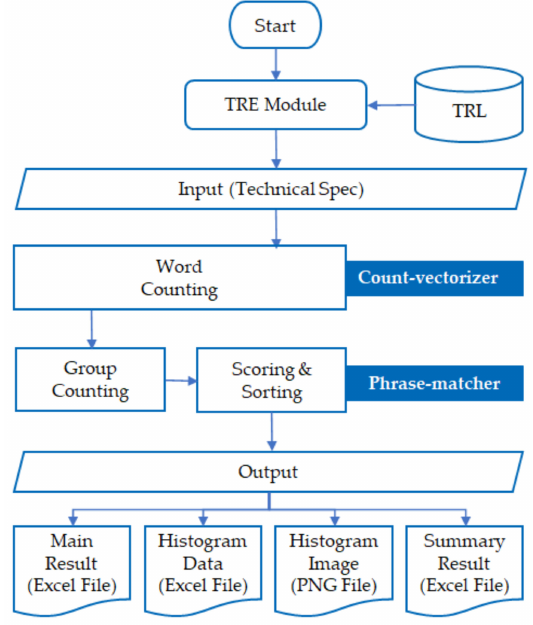
Figure 8. Flowchart of the algorithm concept diagram of the TRE module.